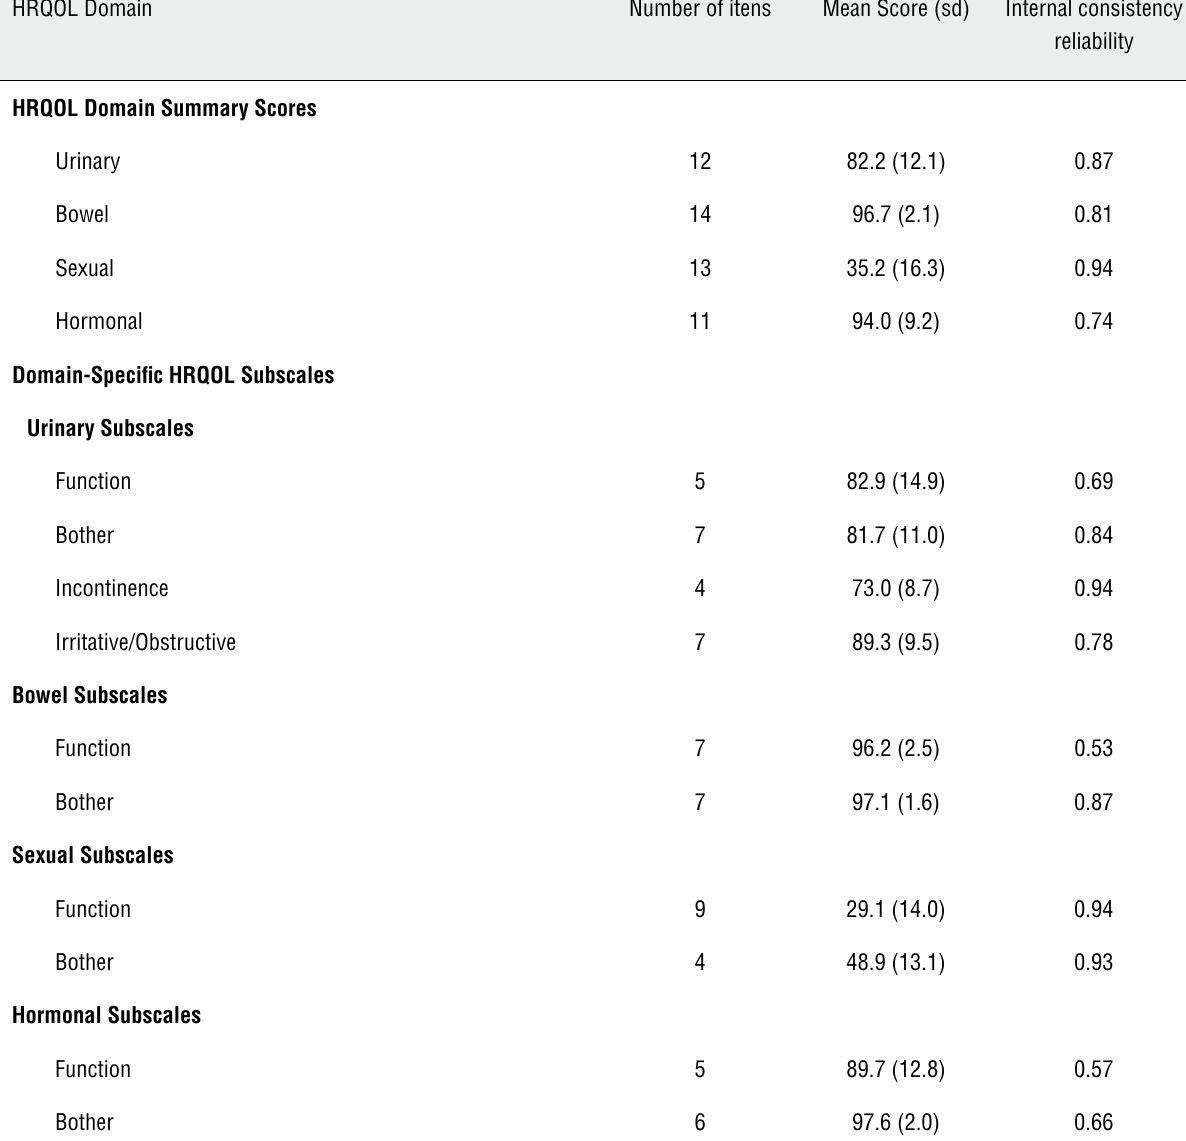
Table 2 - Descriptive measures of